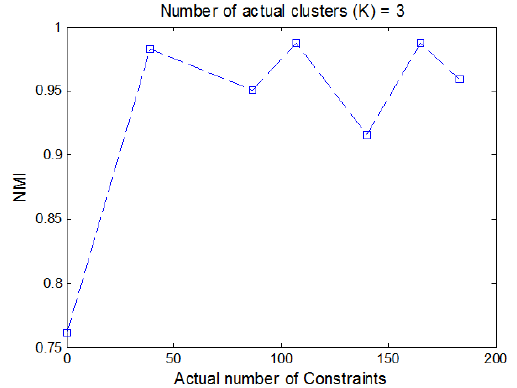
Figure 3. Performance of the constrained version of the algorithm (in terms of NMI (more the better)) with number of “must link”